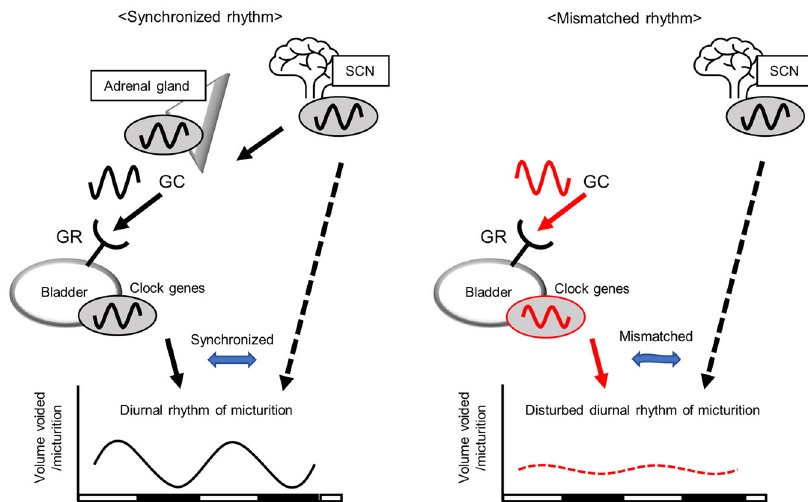
Fig. 8 A schematic diagram of this study. The present study suggests that glucocorticoid secreted by the adrenal cortex acts on the glucocorticoid receptor in the bladder to be an entrainer of the bladder clock and that a mismatch between the central and the peripheral bladder clocks decrease